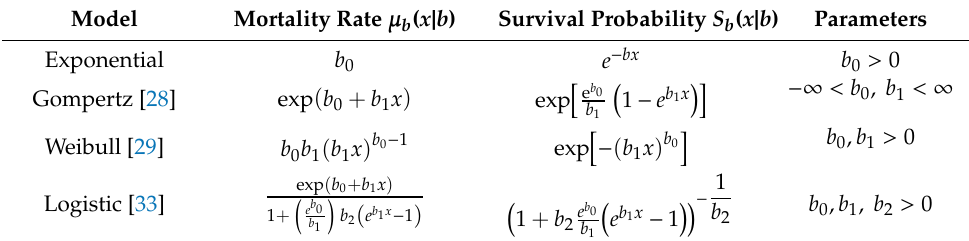
Table 1. Basic mortality and survival probability functions available to test in Bayesian survival trajectory analysis (BaSTA)—namely, exponential, Gompertz, Weibull, and logistic. Additional terms can be added to each model (except exponential) to test di ff erent shapes, namely “Makeham” and “bathtub”. Parameter constraints are also